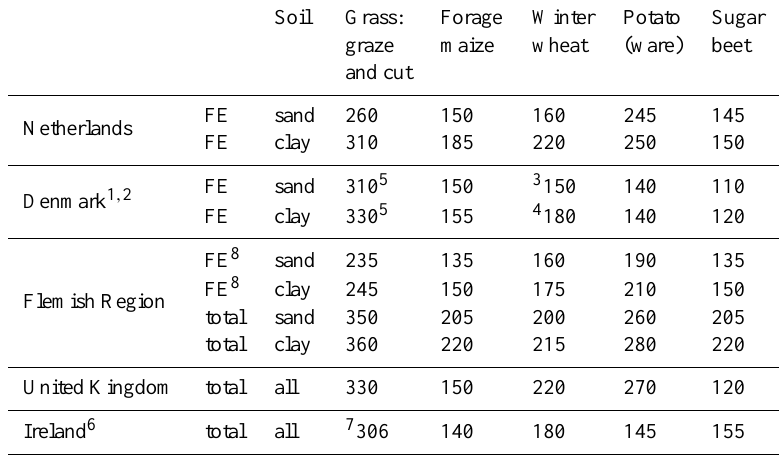
Table 8. Nitrogen application standards (kgN ha − 1 yr − 1 ) for some major crops in the 4th action programs for the NiD expressed either as fertilizer equivalent N (FE) or total N. Soil Grass: Forage Winter Potato Sugar graze maize wheat (ware) beet and cut FE sand 260 150 160 245 145 Netherlands FE clay 310 185 Denmark 1 ,